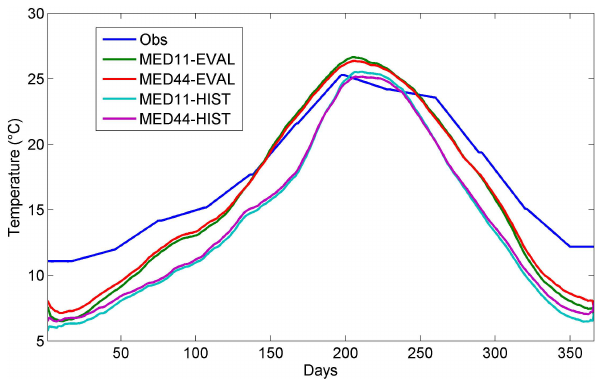
Fig. 7. Reproduction of the temperature cycle in MED11-EVAL, MED44-EVAL, MED11-HIST and MED44-HIST. The observed temperature cycle here is interpolated over the catchment consid- ering a temperature gradient of − 6.5 ◦ Ckm − 1 .